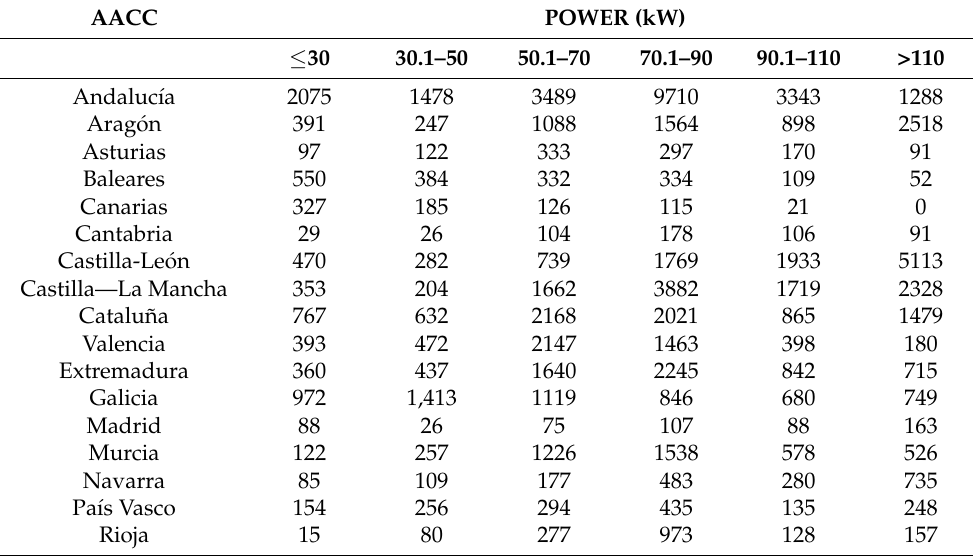
Table 2. Number of tractors registered in the period 2012–2019, by power ranges and Au- tonomous